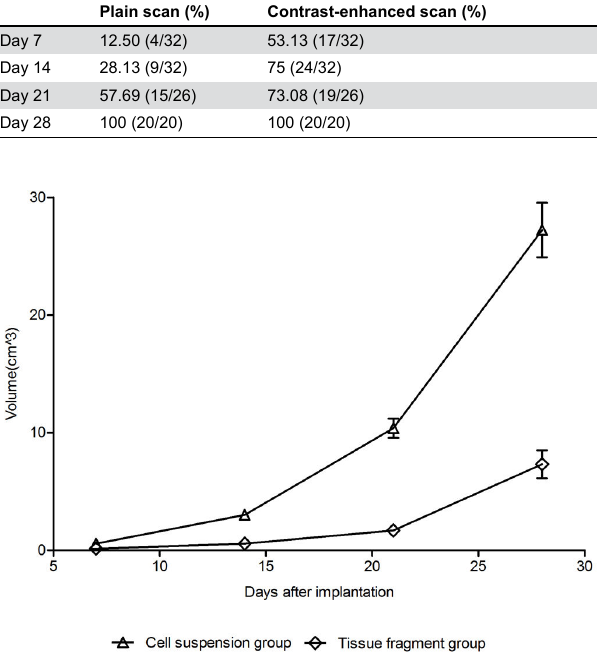
Figure 2. Time-tumor volume curves of the cell suspension group and the tissue fragment group after implantation.